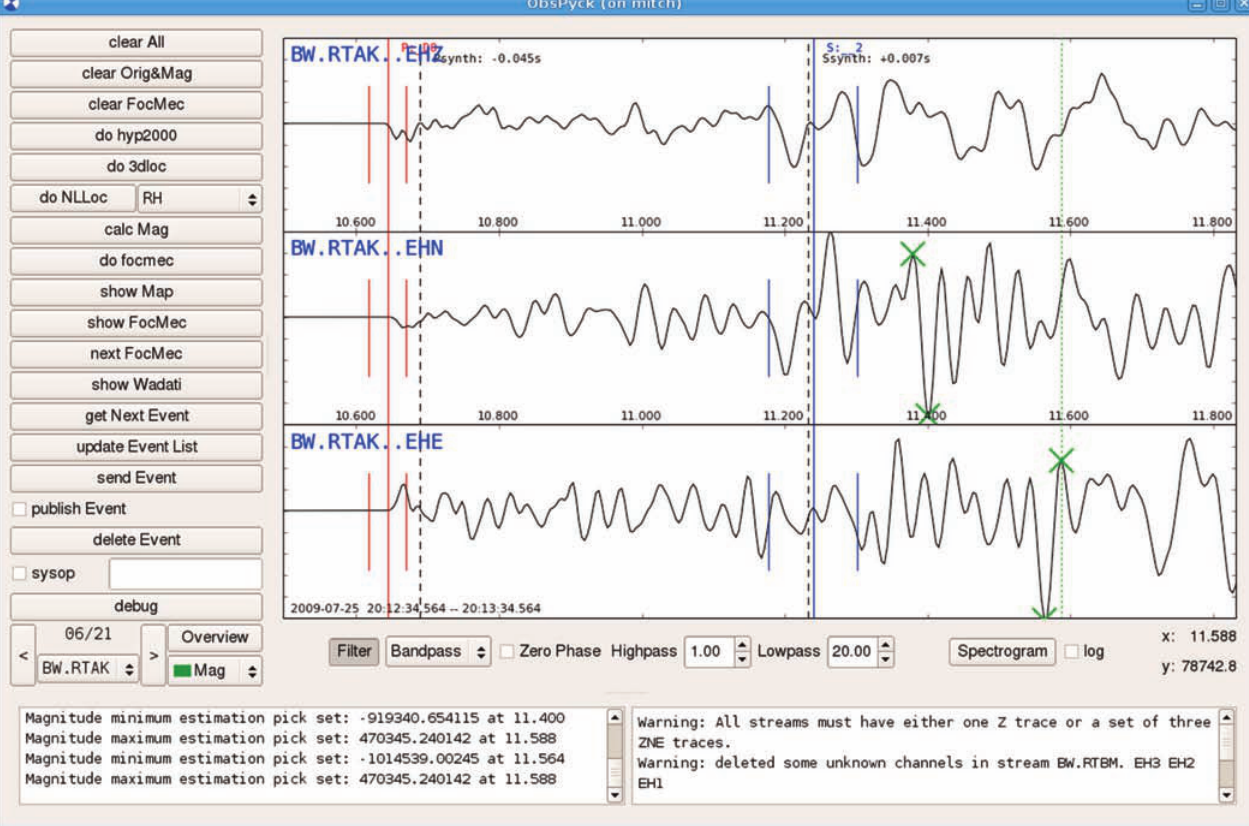
Figure 13. Screenshot: Picking seismic phases and amplitude maxima/minima for magnitude estimation with